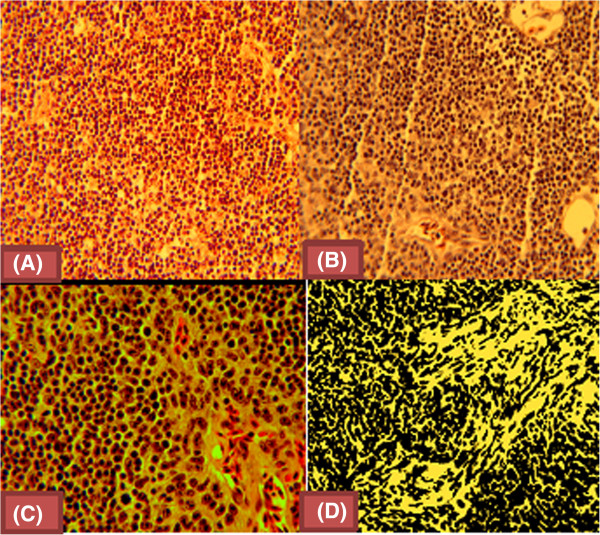
Mixed thymoma; A and B: the tumoral cells were circular or round and more comprised of lymphoblasts with extensive mitotic cells (H&E;20 μm×100), C: Hyperemic and remarkable eosinophils existed among cells (H&E;50 μm×400) D: Note type A and B components. (H&E;30 μm×200).